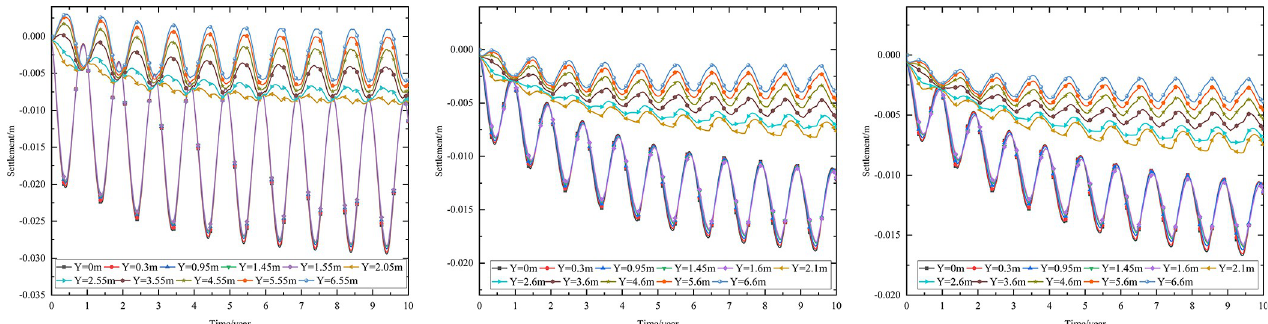
Fig 19. Settlement-time curves of pavement center under the static load of the aircraft at the installation layer thickness of (a) 0.10 m, (b) 0.15 m, and (c) 0.20 m.